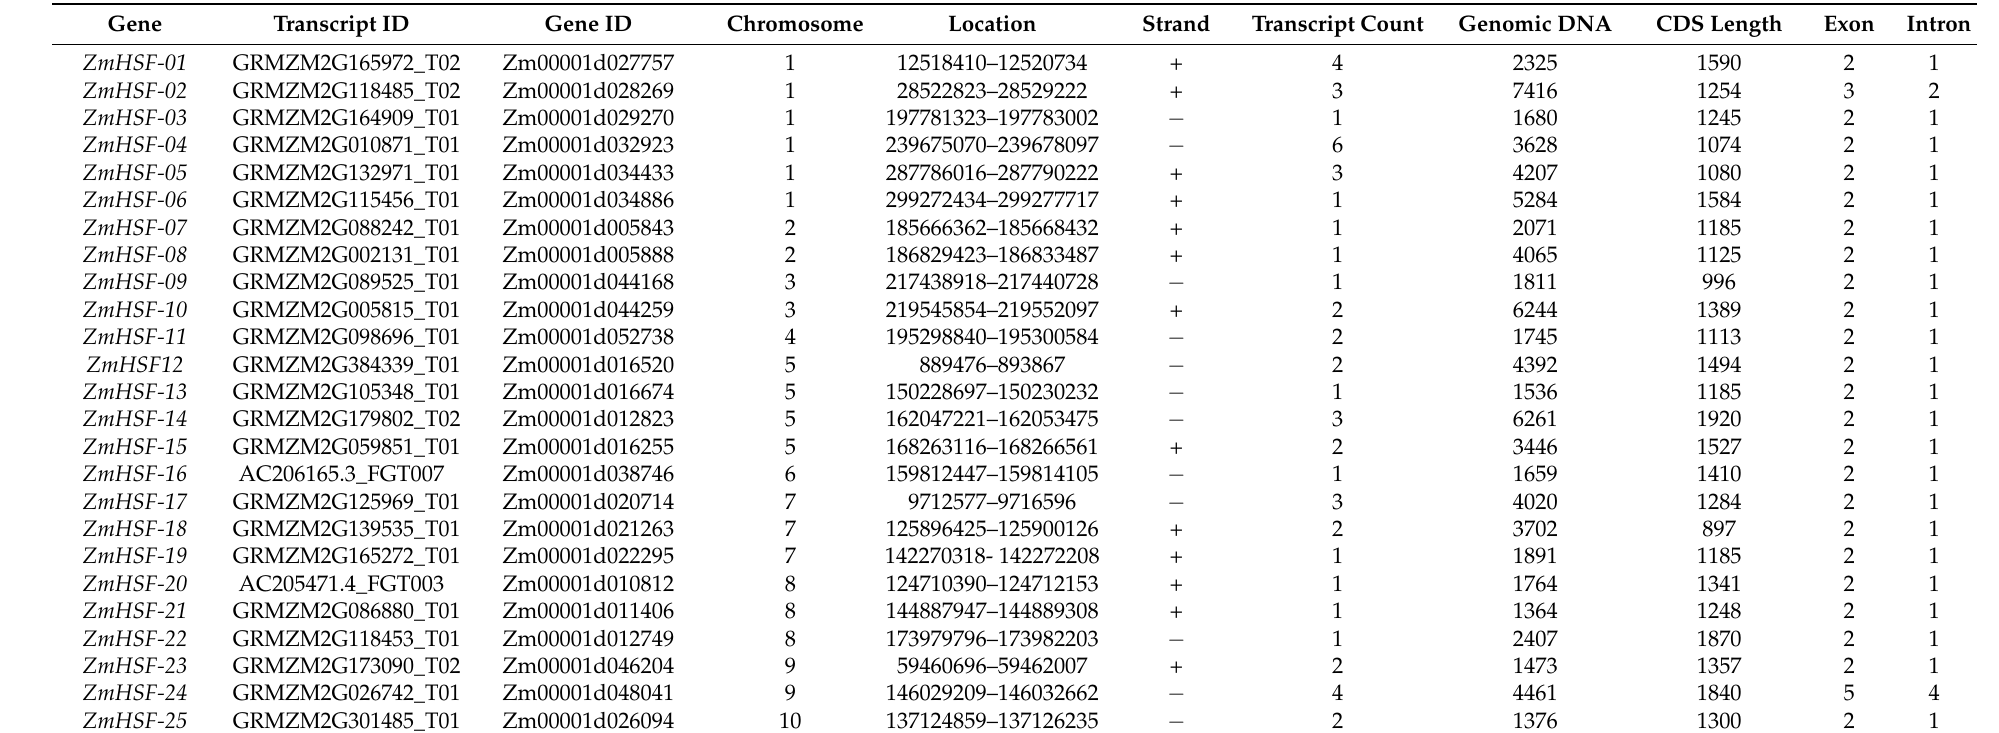
Table 1. Detailed sequence annotation of identified maize HSF